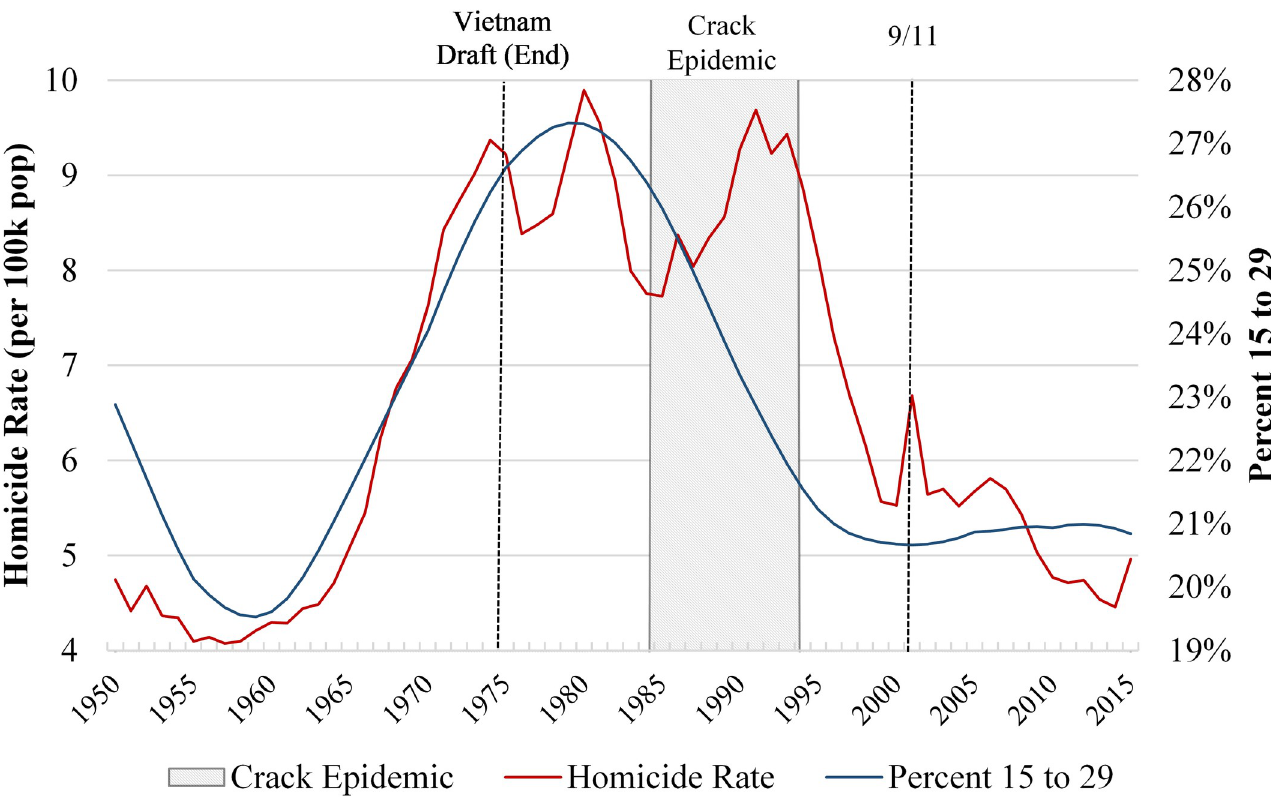
Fig 3. Homicide rate and percent of population 15 to 29 –United States 1950 to 2015. Shown is the annual homicide rate per 100,000 population and the percent of the population aged 15 to 29 in the United States from 1950 to 2015. Homicide data are from the United Nations Office of on Drugs and Crime Homicide Database and the World Health Organization Mortality Database. Data on the Percent 15 to 29 are from the United Nations World Population Prospects.